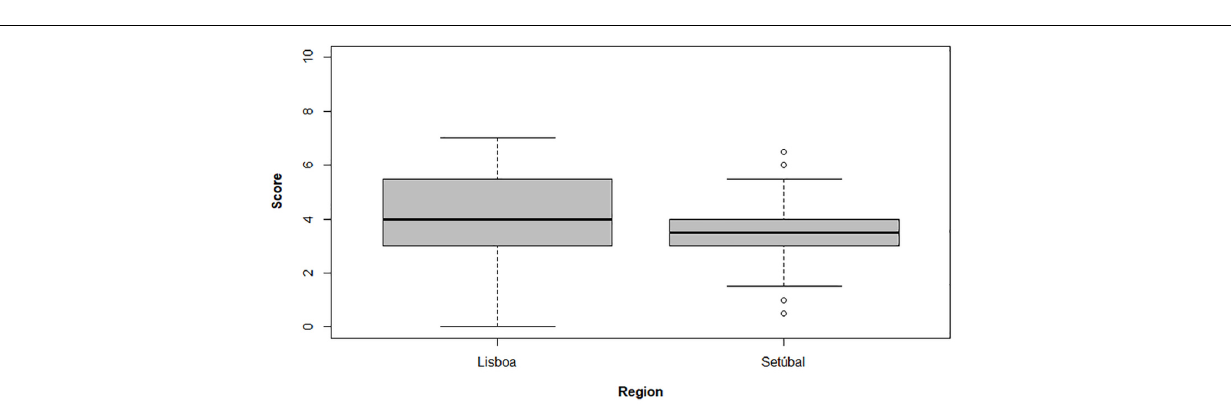
FIGURE 4 | Posttest scores considering school region [Middle line – median; box lower and upper limits – 1st and 3rd quantiles; whisker values – 1.5 times the interquartile range from the top (or bottom) of the box to the furthest datum; points – outliers].